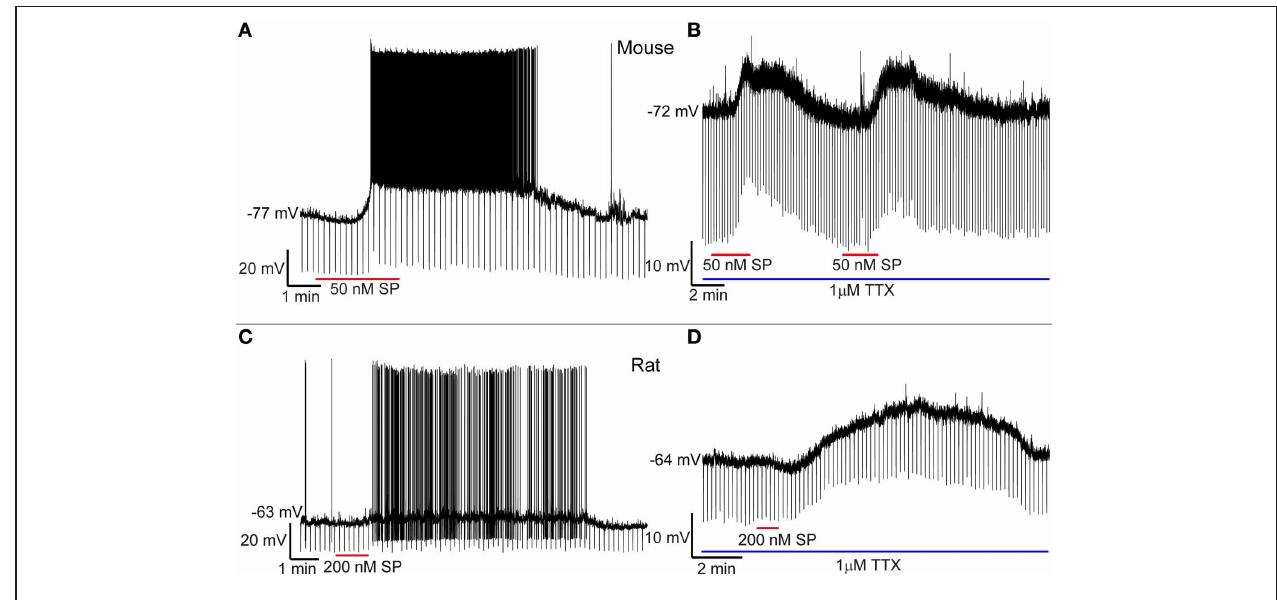
blockade of voltage-dependent Na + channels with TTX. (C) SP increases the firing rate of cortical NK1 + neurons in the rat. (D) Under TTX blockade, rat NK1 + cortical neurons can be depolarized for a prolonged period despite the short duration of SP bath